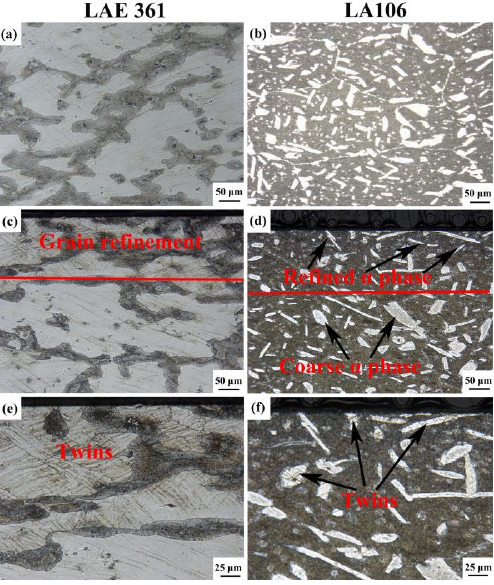
Figure 2. Microstructures of LAE361 and LAE106 Mg-Li alloys before the UNSM treatment ( a , b ) and after the UNSM treatment ( c – f ).